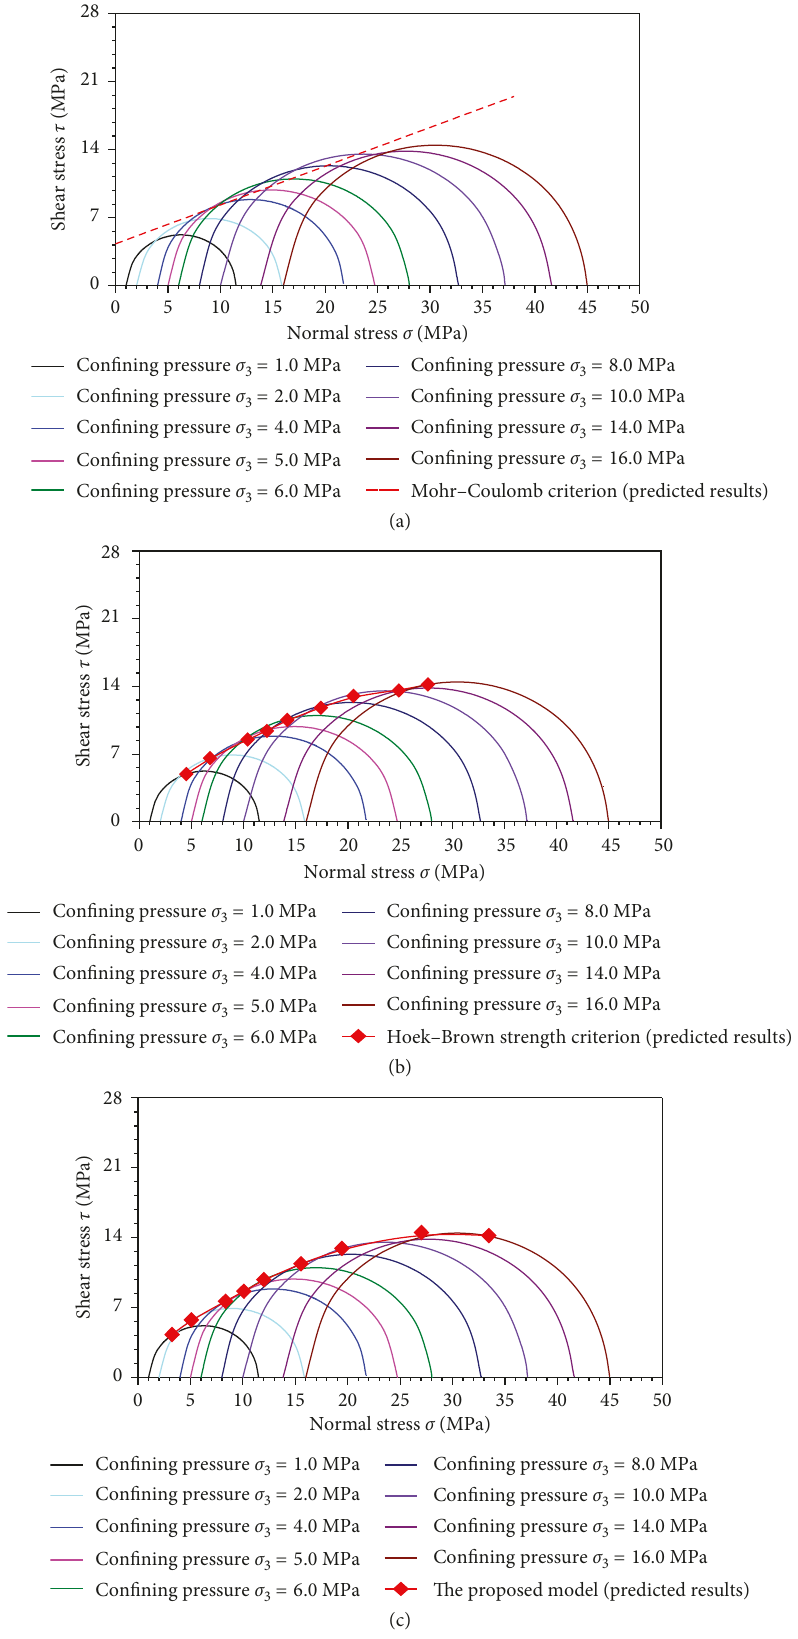
Figure 6: Nonlinear strength envelope for frozen sandy soils under various confining pressures. Comparisons between (a) Mohr–Coulomb strength criterion and experimental results, (b) Hoek–Brown strength criterion and experimental results, and (c) the proposed model and experimental